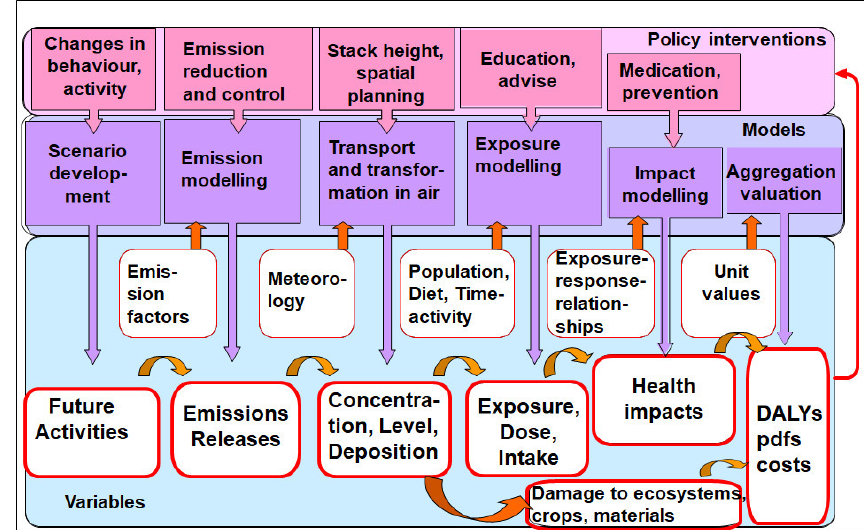
Figure 19. Schematic presentation of the use of models and the flow of data in the enhanced impact pathway approach (Friedrich,